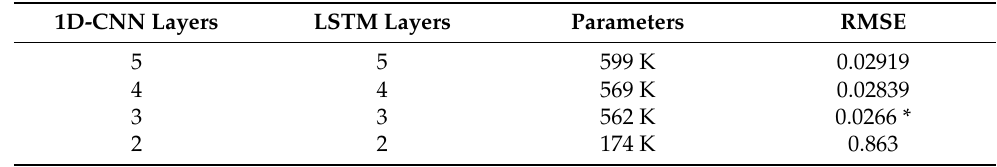
Table 4. Ablation studies of the proposed model on the traffic speed dataset.